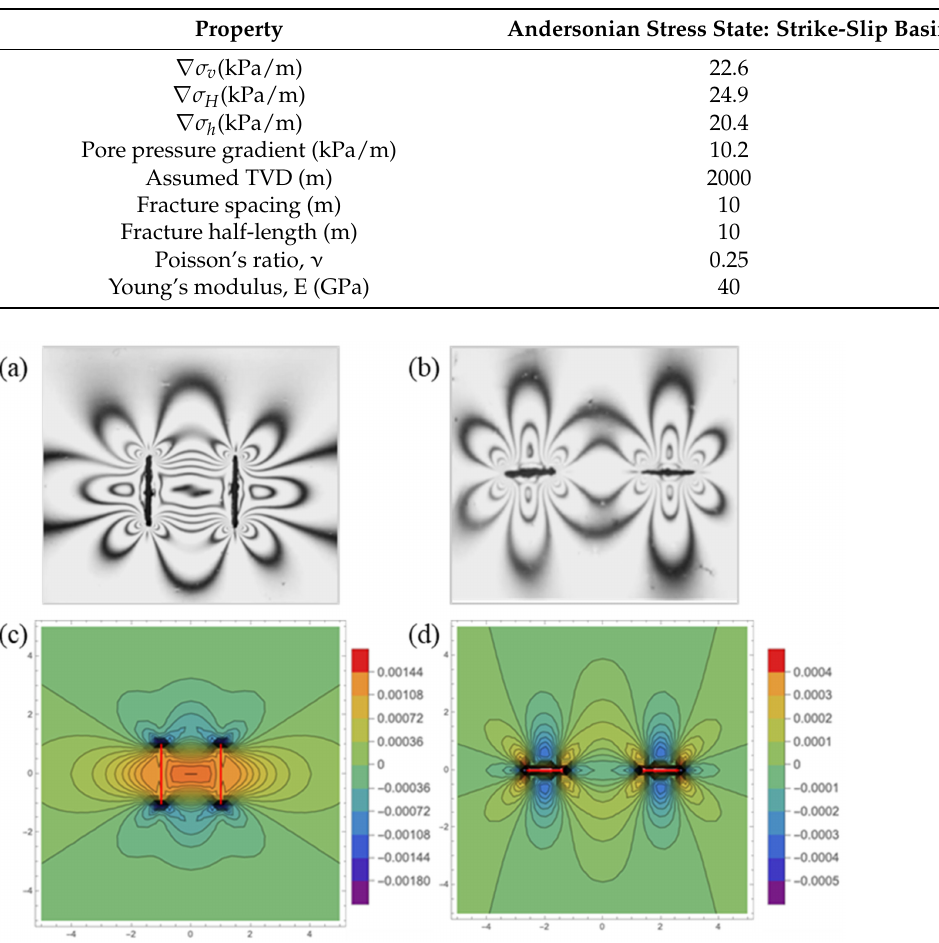
Figure 2. ( a , b ) Color fringes in photo-elastic methods visualizing strain magnitude contours around two fractures stressed in the vertical direction of the image, which is dynamically simi- lar to the case of pressure-loaded fractures. Photo-elastic method modified from Stepanova et al. [21]. ( c , d ) Corresponding solutions obtained with LSM code using input values given in Table 1 and algorithms summarized in Section 2 of this paper. The color bar shows strain